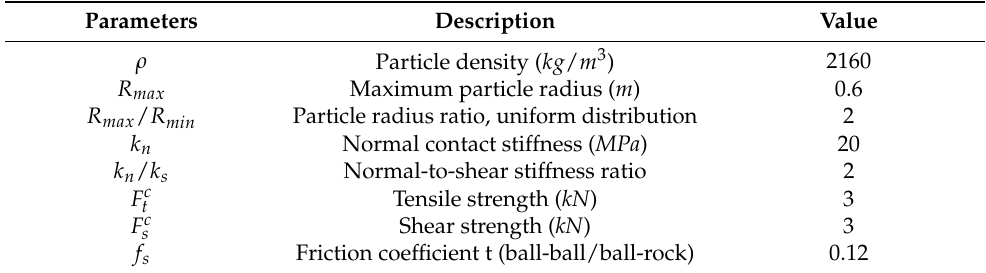
Table 2. Meso-mechanical parameters of